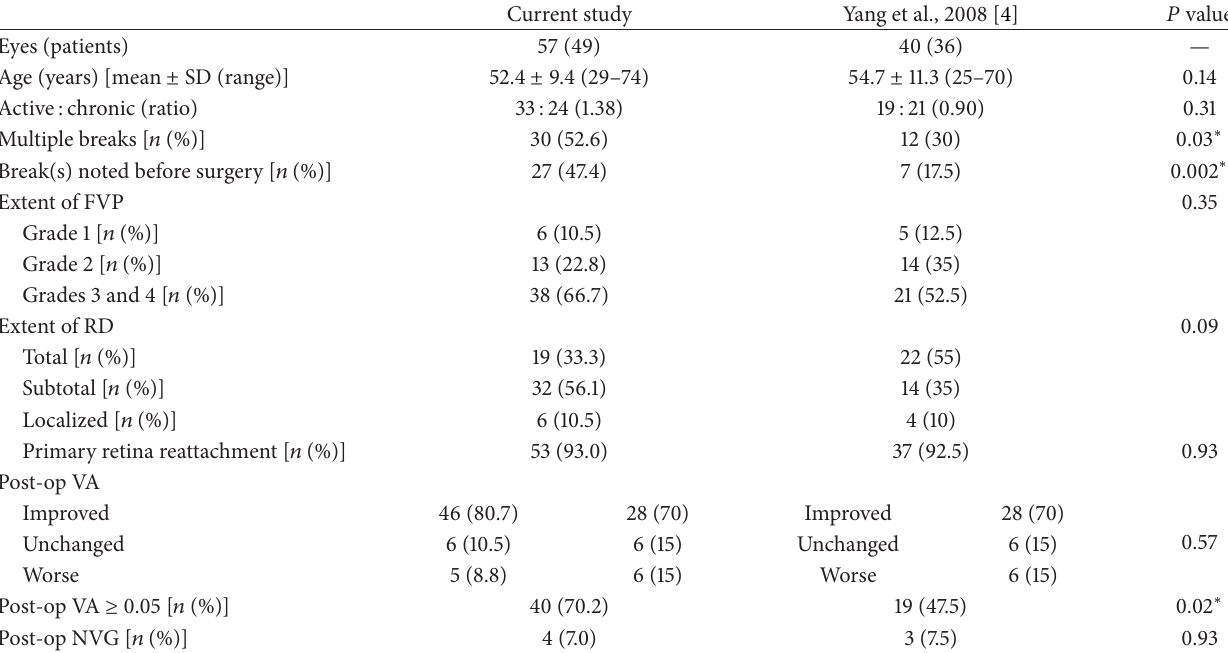
Table 4: Comparison of the present study and the previous